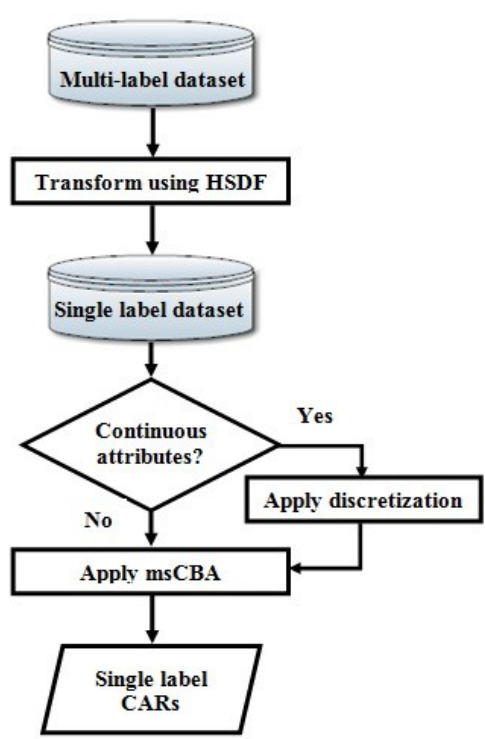
Figure 2. ML-CBA algorithm transformation